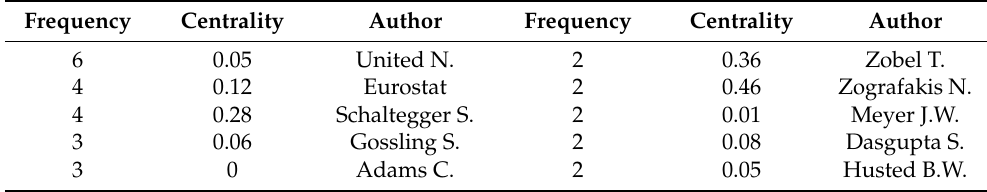
Table 3. Top 10 most-cited authors with co-citation frequency.